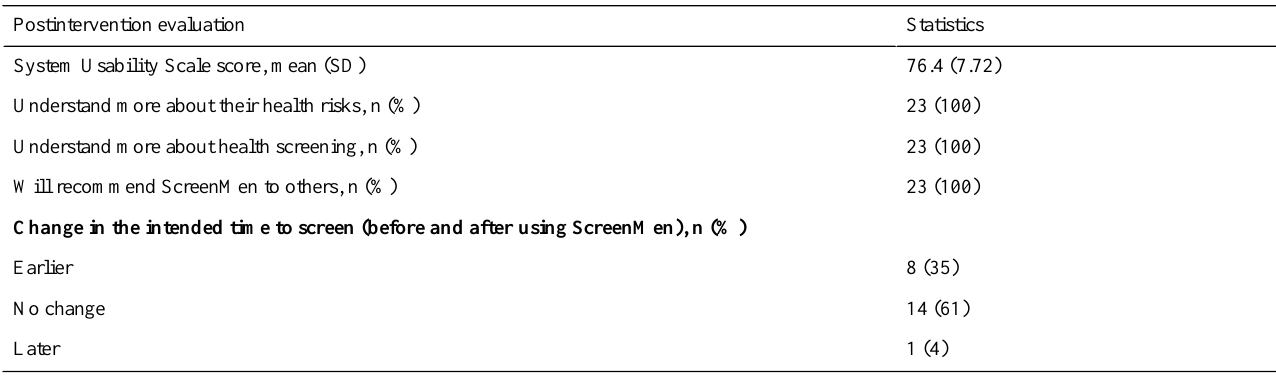
Table 3. Quantitative evaluation after using the ScreenMen (N=23).